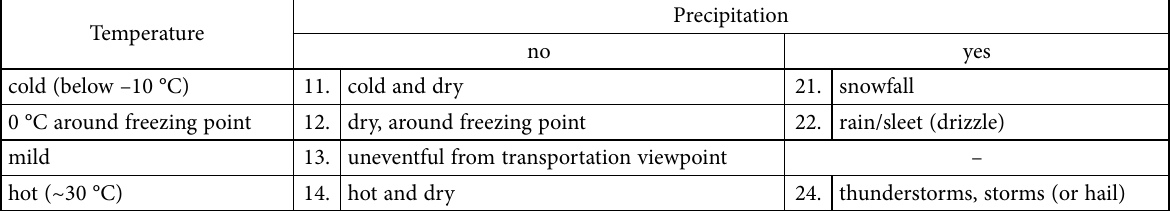
Table 2. Weather categories according to the temperature and precipitation ( source : research by the authors)